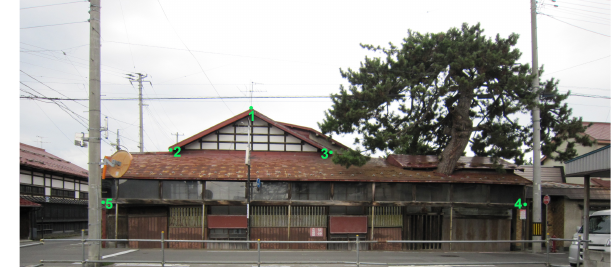
Figure 8. Feature points manually chosen for the Former Matsuno-Yu building.